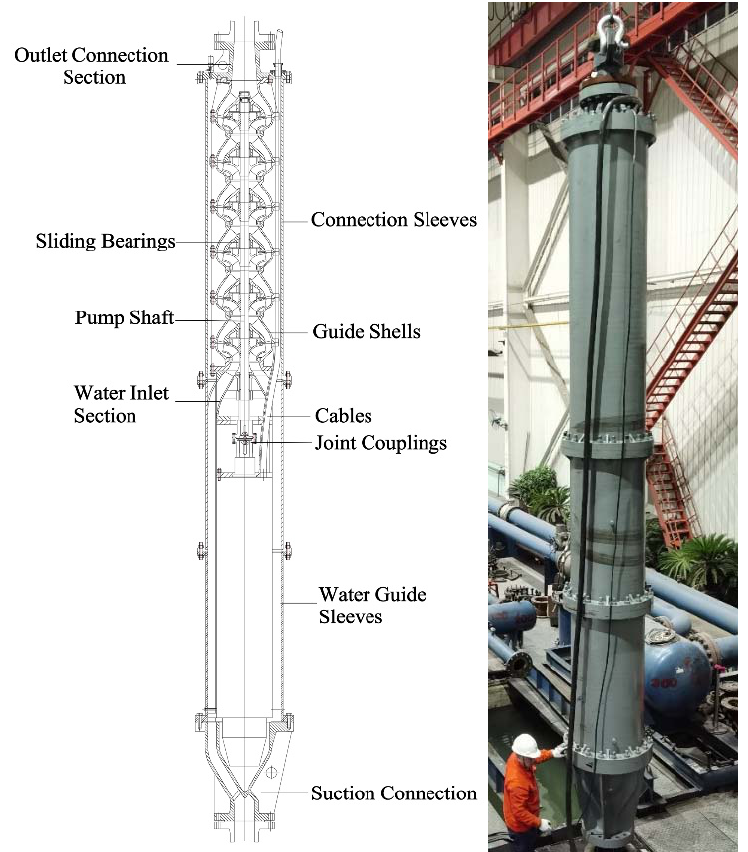
Figure 1. Overall view of the electric pump.